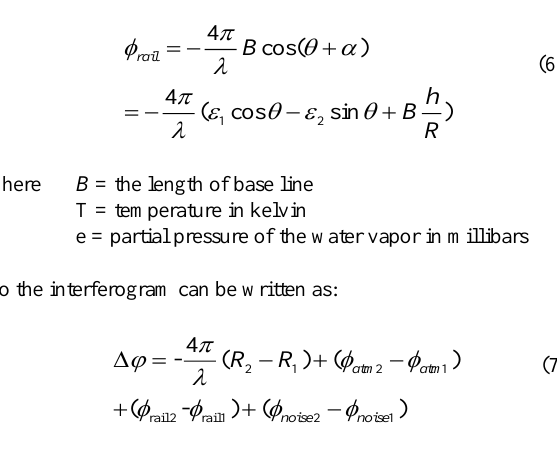
Figure 2. Rail error in the azimuth direction. (a) Interferogram containing 10mm rail error in the azimuth direction. (b)10mm rail error competition result. (c) Interferogram containing 70mm rail error in the azimuth direction. (d)70mm rail error compensation